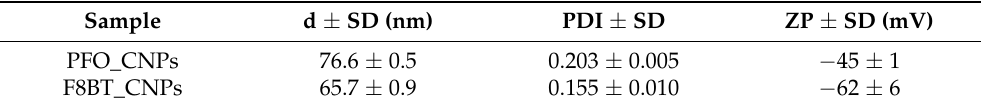
Table 1. Hydrodynamic diameter (d), polydispersity (PDI) and Zeta Potential (ZP) of PFO and F8BT